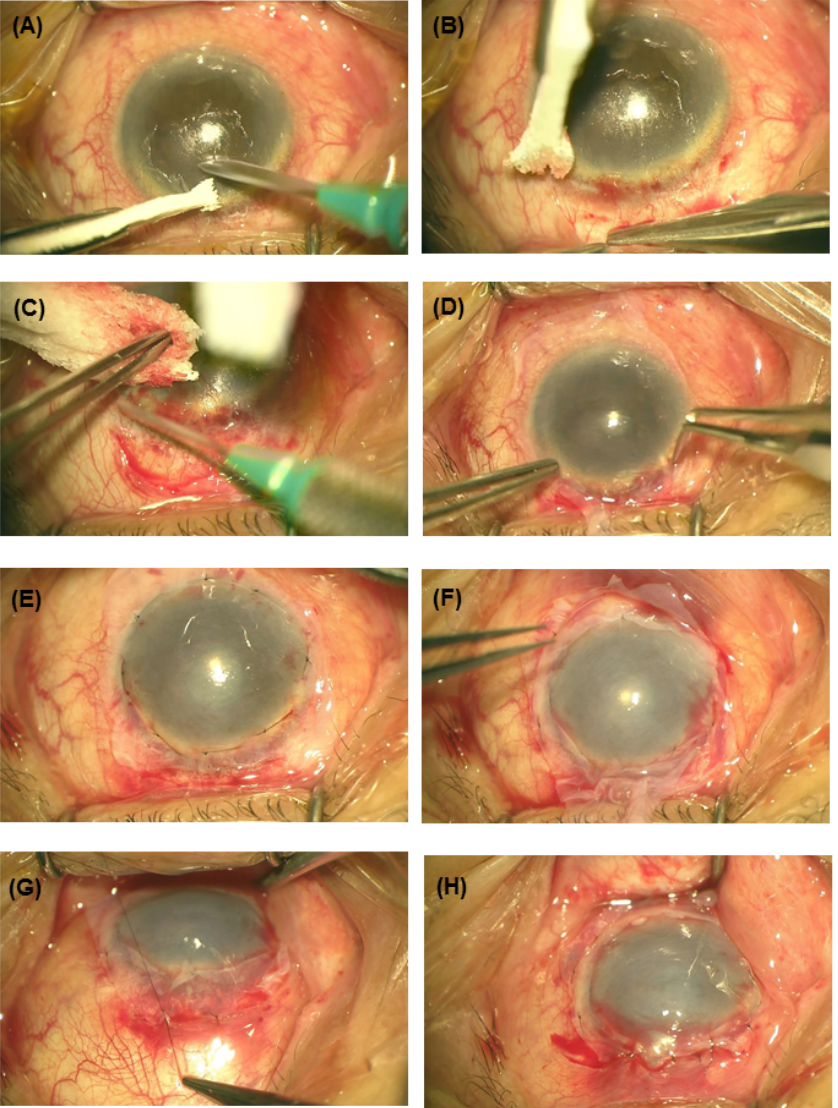
Figure 1. The surgical procedures of the modified amnion-assisted conjunctival epithelial redirection (ACER). ( A ) Conjunctival tissue on the cornea was dissected and peeled off using the Beaver blade. ( B , C ) The conjunctiva in the localized area of limbal stem cell deficiency (LSCD) was peritomized and recessed. ( D , E ) The inner amniotic membrane (AM) was placed and fixed onto the cornea with interrupted 10-0 nylon sutures. ( F ) The outer AM was placed on top of the inlay and the margin of the outer AM was anchored to the adjacent conjunctiva with interrupted 10-0 nylon sutures ( G , H ). The edge of the AM in the area of the partial LSCD was sutured to the free edge of the peritomized conjunctiva with additional interrupted 10-0 nylon sutures.